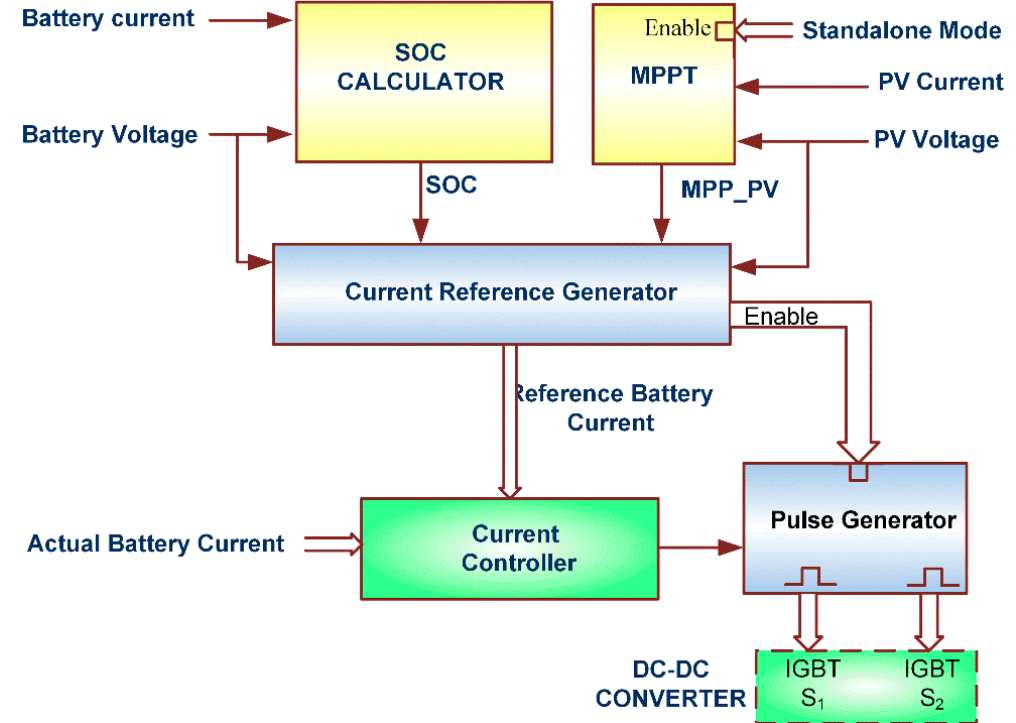
Figure 6. Control diagram for the bi-directional chopper in PV-ESS.